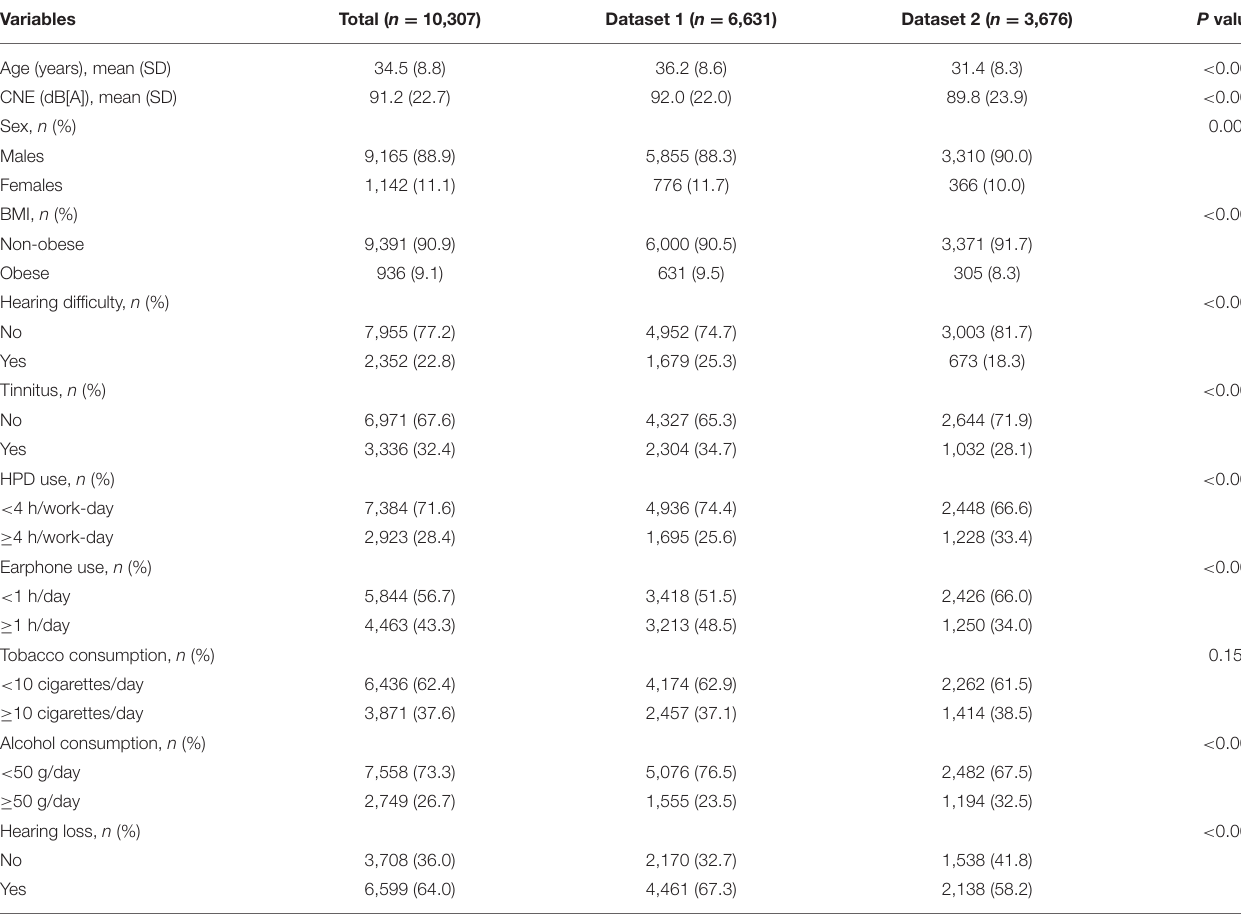
TABLE 1 | Characteristics of subjects in different